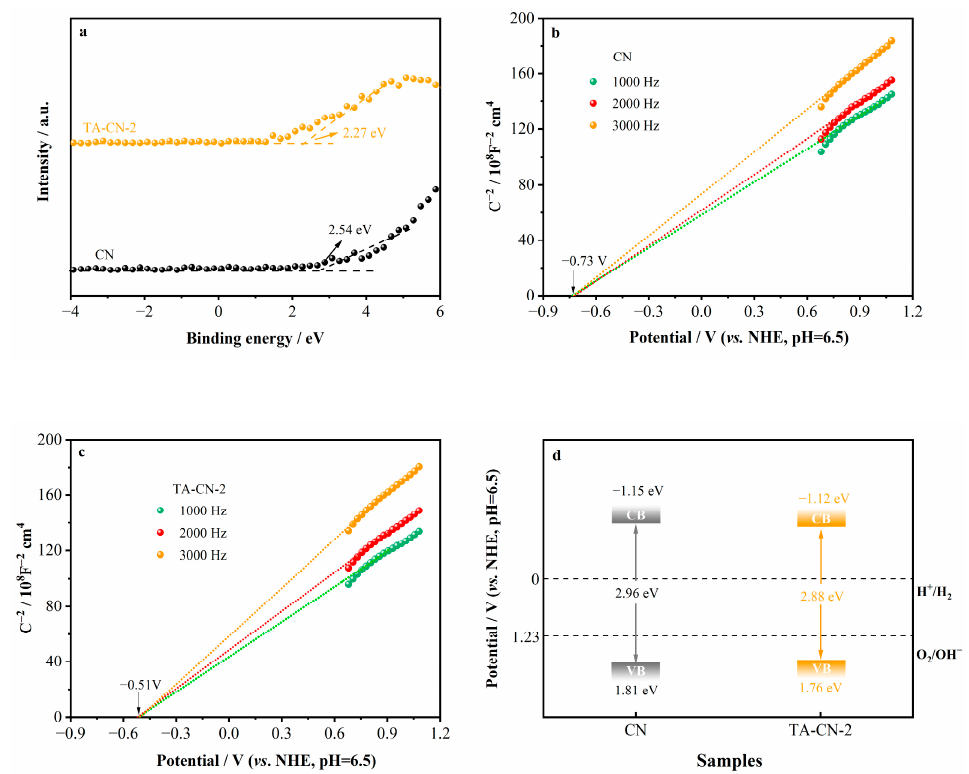
Figure 9. ( a ) XPS valance spectra, ( b , c ) Mott-Schottky plots and ( d ) band structure diagram of CN and TA-CN-2.